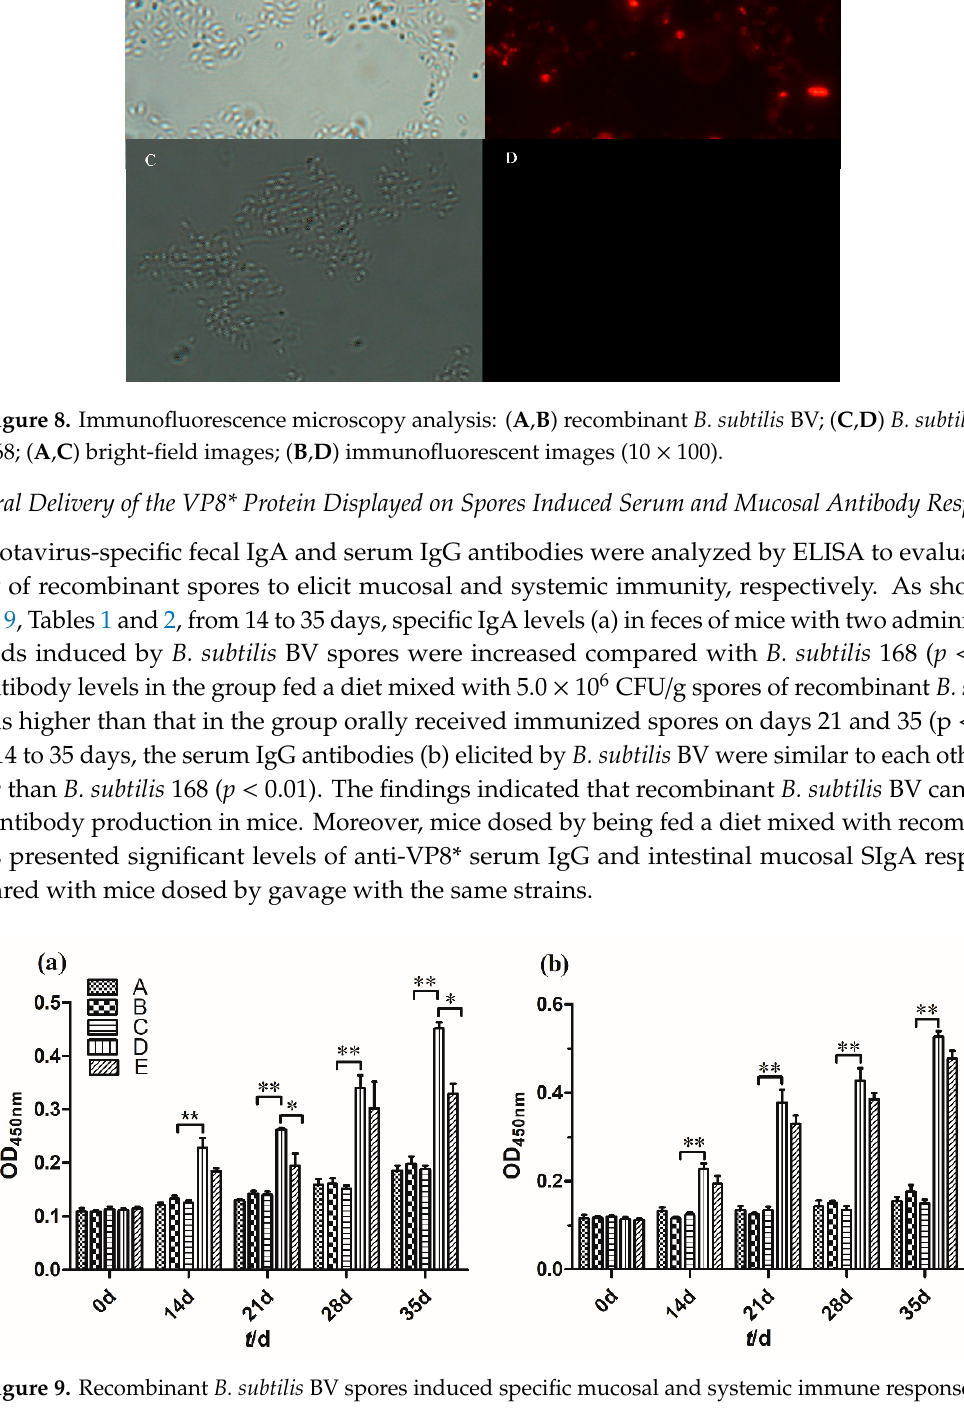
Figure 9. Recombinant B. subtilis BV spores induced specific mucosal and systemic immune responses